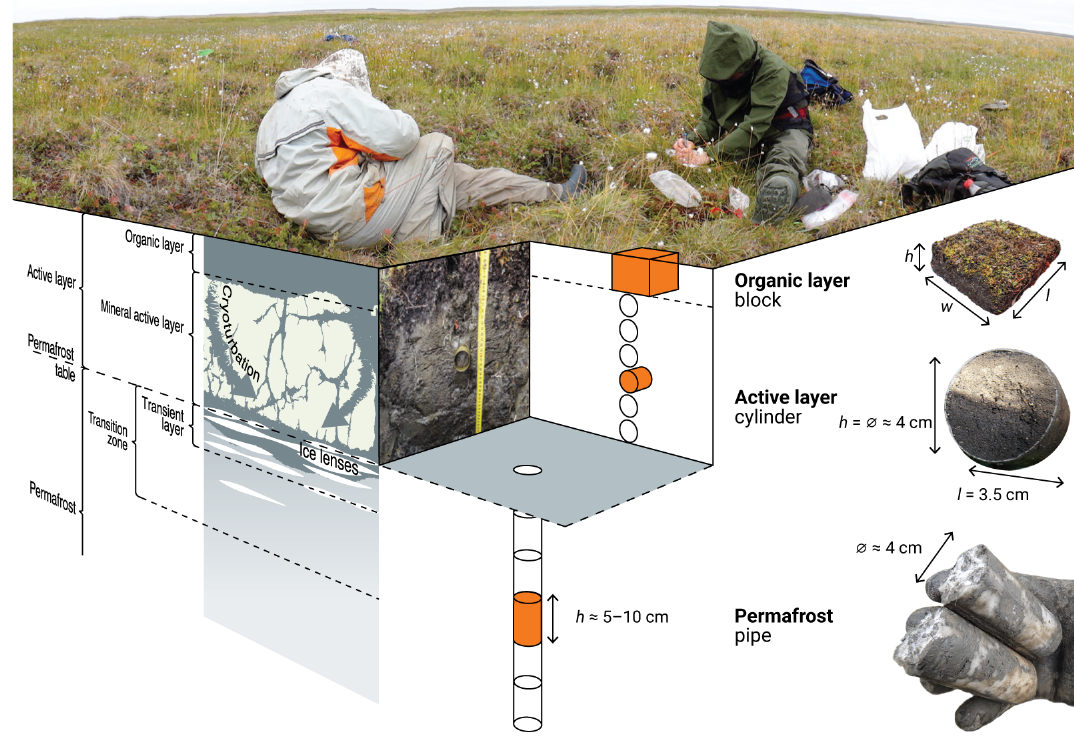
Figure 2. A three-dimensional field sampling protocol with typical soil layers in permafrost ground (reprinted from Weiss, 2017, p. 12). The orange shapes represent the different sampling techniques for organic surface layer (block), active layer sample from an excavated pit (fixed volume cylinder), and permafrost sampling (steel